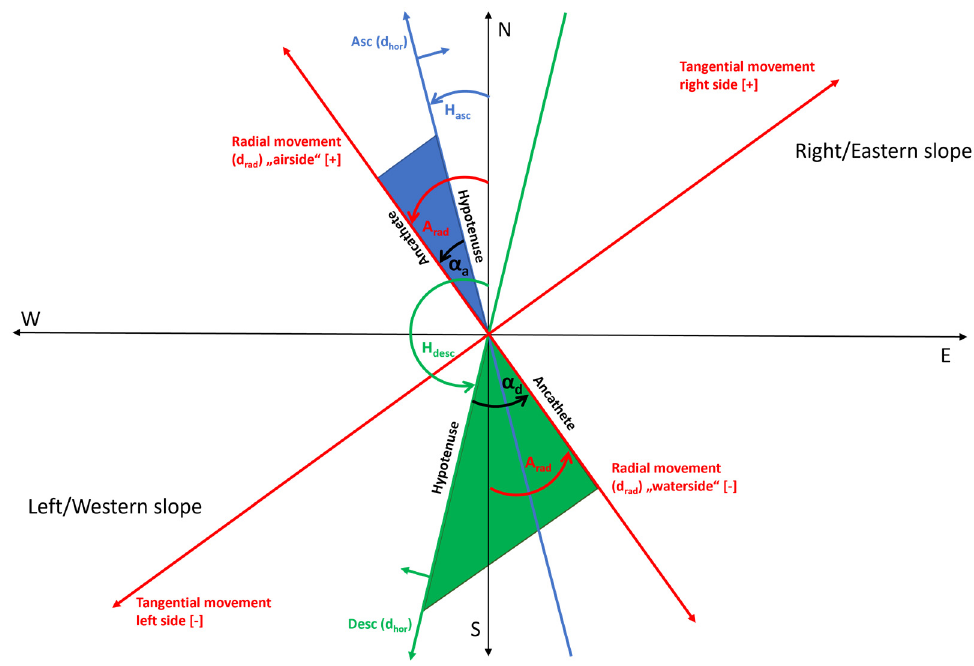
Figure 5. Illustration of the computation of the radial deformation in this study, applying the dam’s precise model. Blue areas and lines correspond to the ascending direction, green to the descending direction, shown here for the sake of completeness.